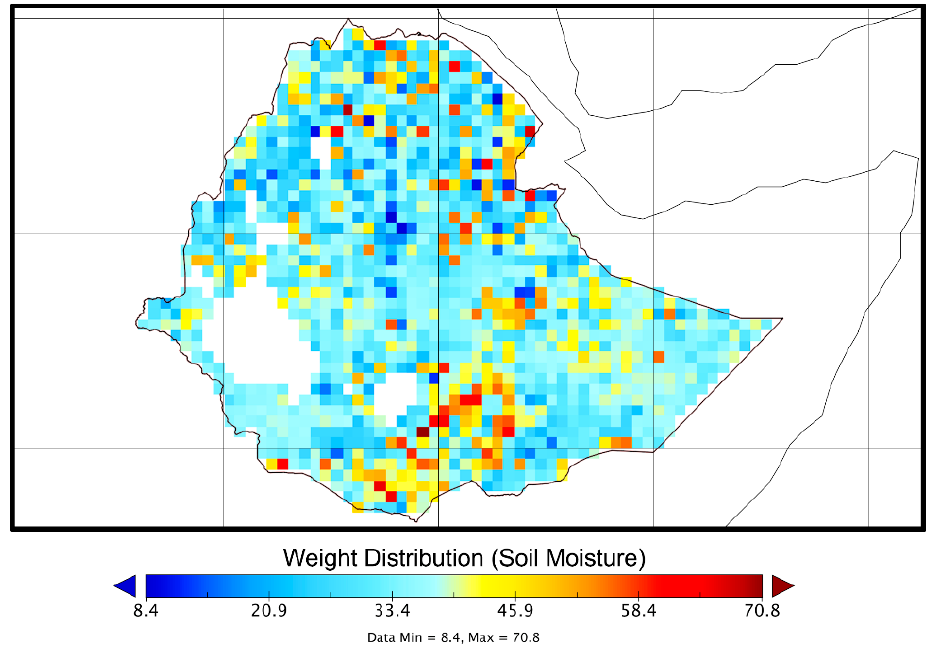
Figure 4. Weight Distribution for the Soil Moisture Drought Index. The masking is related to vegetation density and complex topography. The average weight of the soil moisture component is 34.8%.